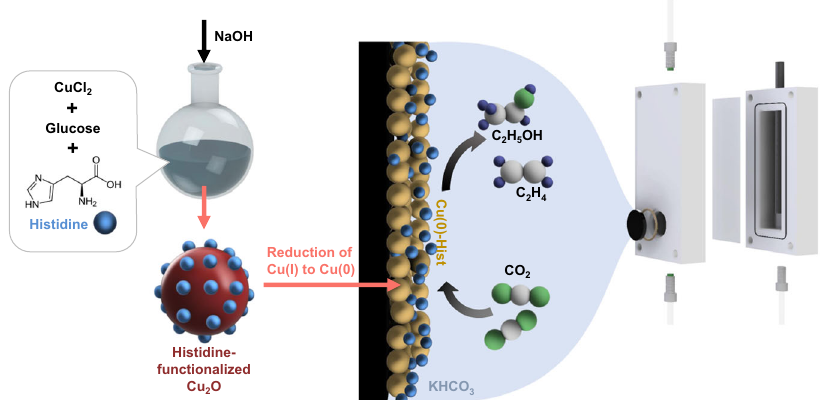
Fig. 1 | Preparation of histidine functionalised Cu 2 O and its subsequent use in CO 2 RR. The histidine remains on the surface after the in-situ reduction of Cu 2 O to Cu during catalysis, boosting reaction selectivity towards C 2+ products. Other